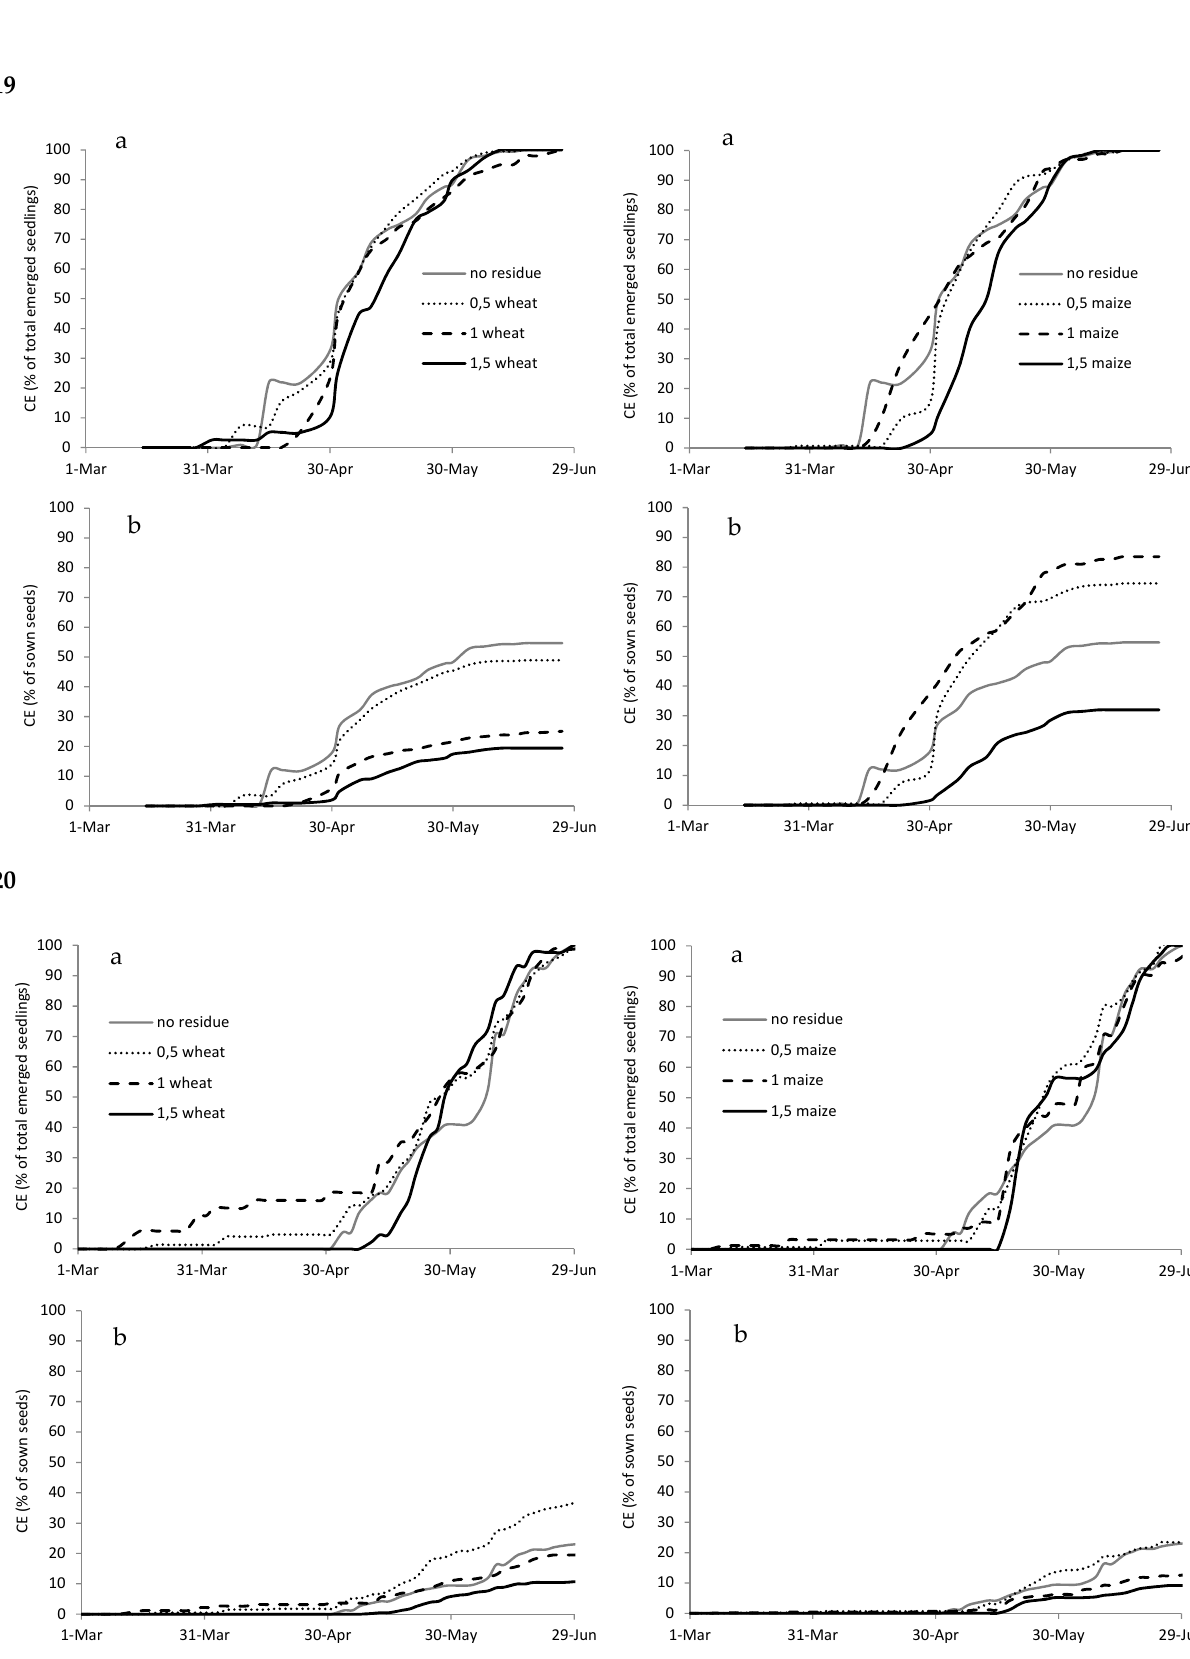
Figure A4. Cumulated emergence (CE) expressed as percentage of total emerged seedlings ( a ) and as percentage of sown seeds ( b ) of Digitaria sanguinalis in 2019 and 2020 with different types (wheat on the left and maize on the right) and amounts of crop